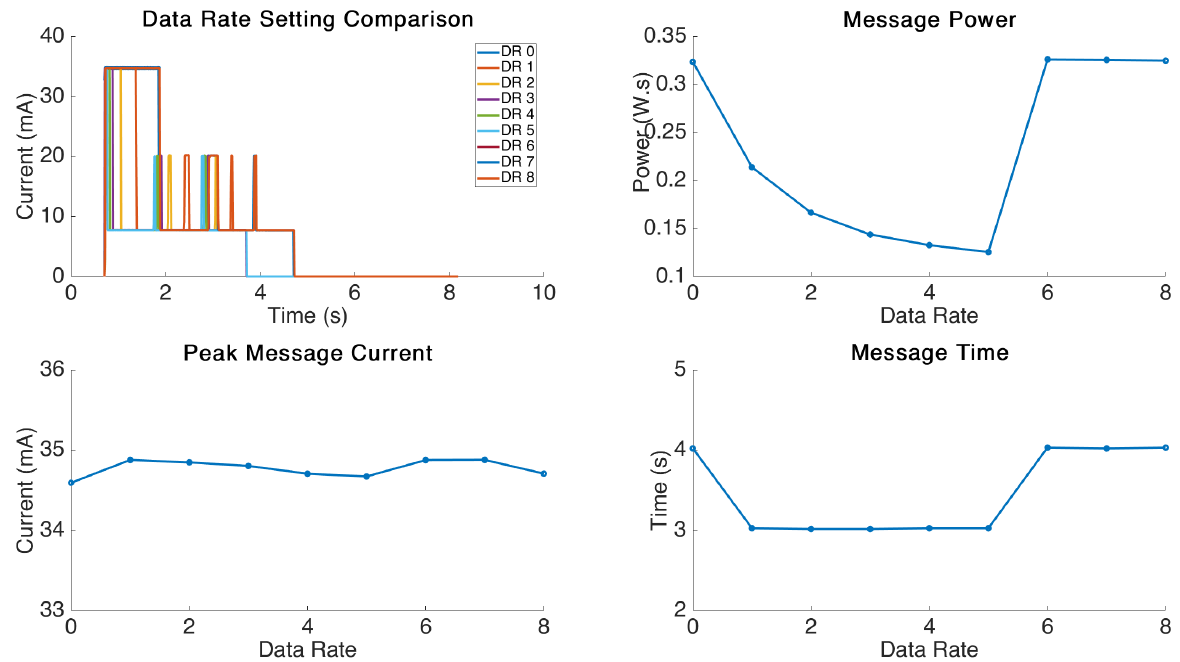
Figure 5. Data Rate setting